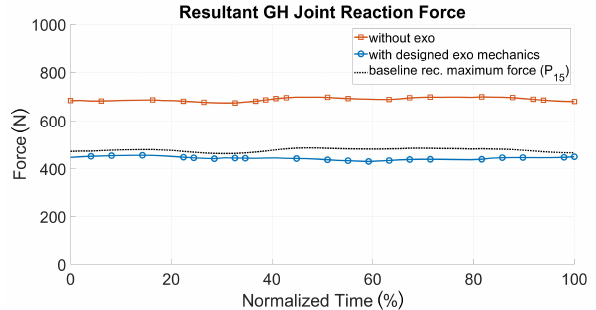
Figure 17. Representative joint loads of the right shoulder for the pull scenario with (blue line) and without the exoskeleton (red line) in comparison with recommended manual pulling (dotted black line) [26].